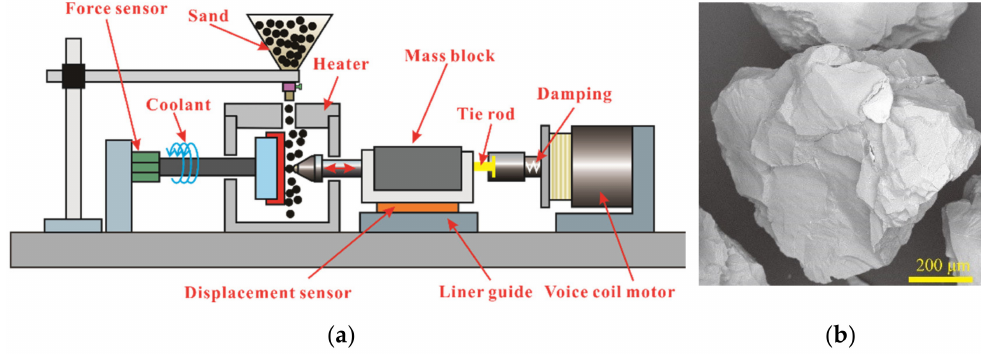
Figure 2. Impact test system. ( a ) Schematic of impact wear tester, and ( b ) SEM image of